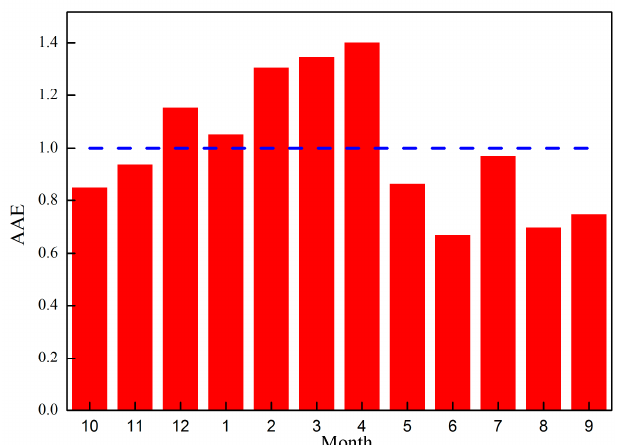
Figure7. ThemonthlyvariationofAAEs, Figure 7. The monthly variation of AAEs, restricted between 470 nm and 660 nm during the study period.